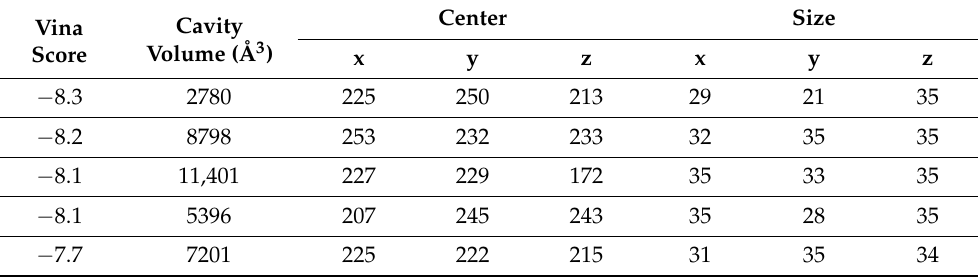
Table 4. Binding mode and the related cavity size based on the results of CB-Dock for quercetin and the receptor of 6VSB.